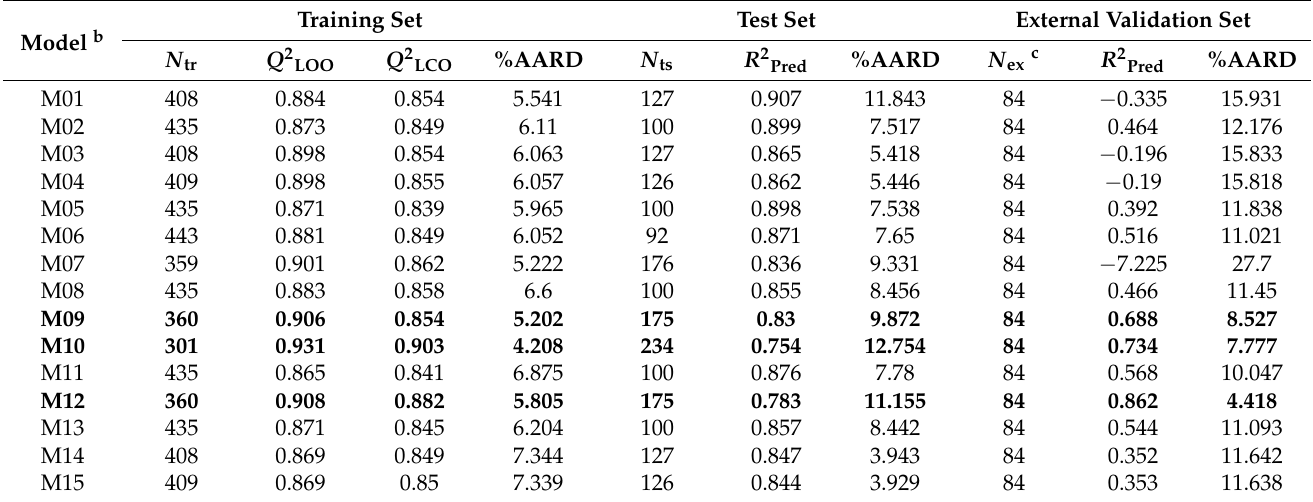
Table 2. Internal and external predictivity for the top 15 regression models against the training, test and external validation sets a .